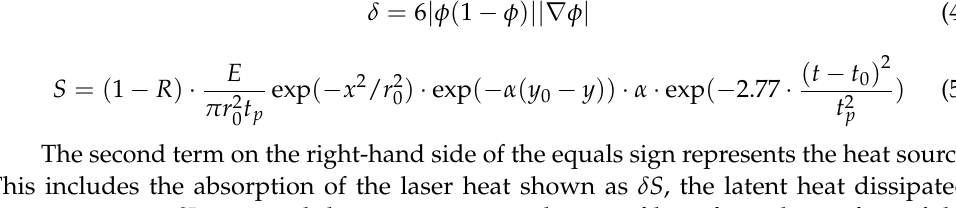
Table 1. Key parameter list of the simulation.